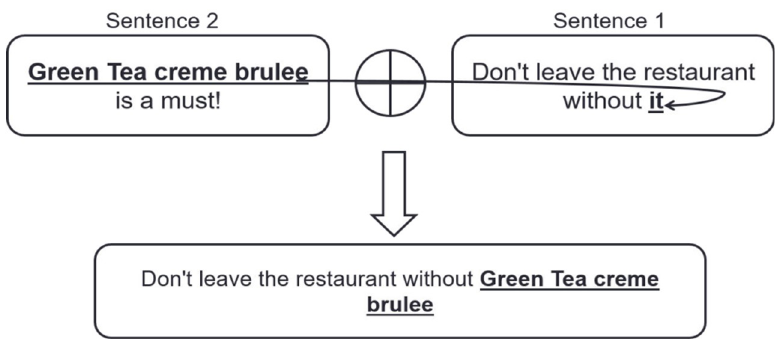
Figure 7. Personal pronoun substitution from context.